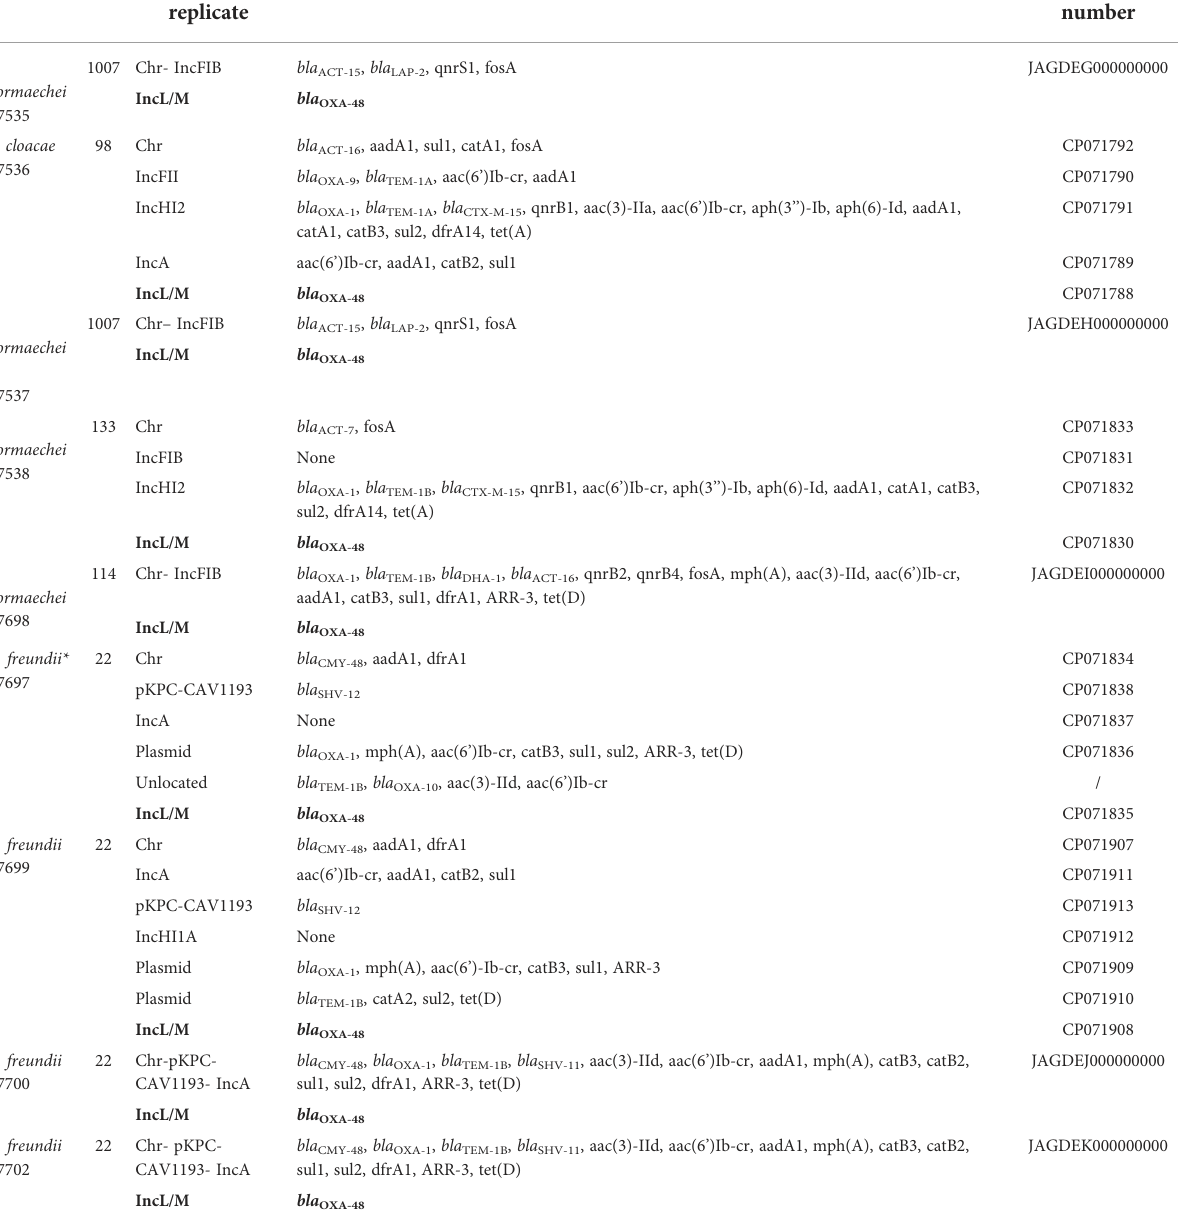
TABLE 2 Genomic analysis of C. freundii and Enterobacter sp. strains. Isolate